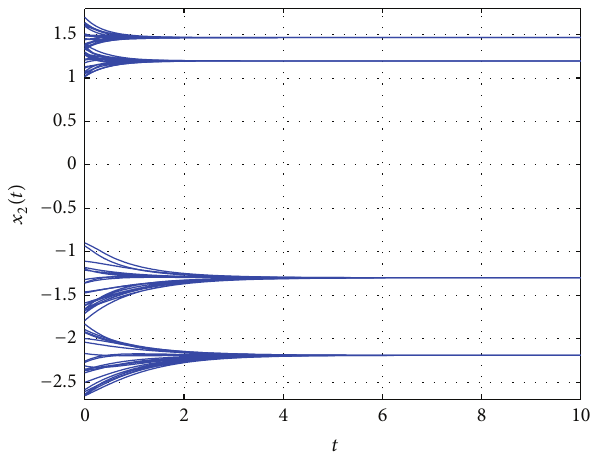
Figure 3: Transient behavior of 𝑥 2 in Example 1.